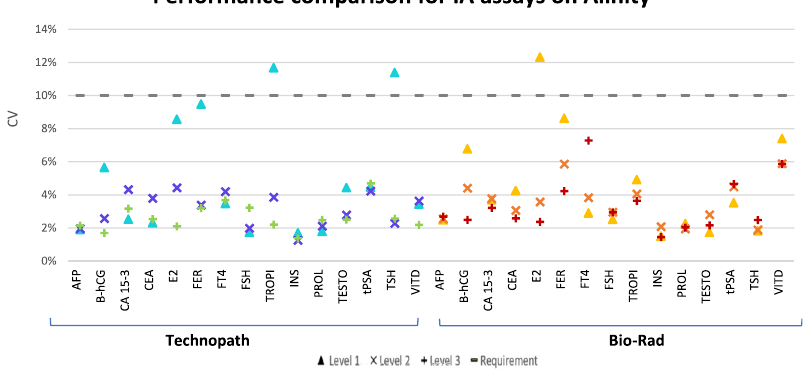
Figure 2: Performance comparison for 15 IAs on the Alinity analyzer using QC materials from two different manufacturers, Technopath and Bio-Rad. CV=coef fi cient of variation. The limits used are based on results from several consensus meetings between the medical laboratory and the medical doctors from our hospital. They may be different from other recommendations but they follow the Milan hierarchy as we have the clinical evidence (8). AFP, alpha-fetoprotein; ß-HCG, beta human chorionic gonadotropin; CA 15-3, cancer antigen 15-3; CEA, carcinoembryonic antigen; E2, estradiol; FER, ferritin; FT4, free thyroxine; FSH, follicle-stimulating hormone; TROPI, troponin I; cardiac high-sensitive; INS, insulin; PROL, prolactin; TESTO, testosterone; tPSA, prostate speci fi c antigen; TSH, thyroid-stimulating hormone; VITD, vitamin D.